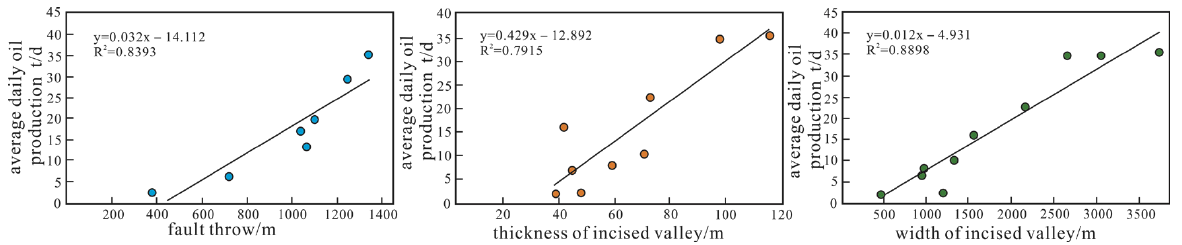
Figure 11. The relationship between oil production and fault throw, thickness, and width of incised valley.